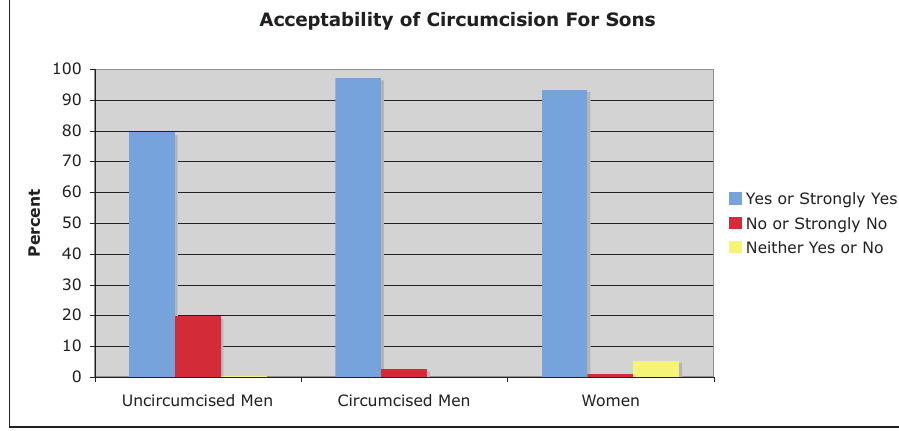
Figure 2: Acceptance of male circumcision for male children in three groups after the provision of information on health benefits Acceptability of Circumcision For